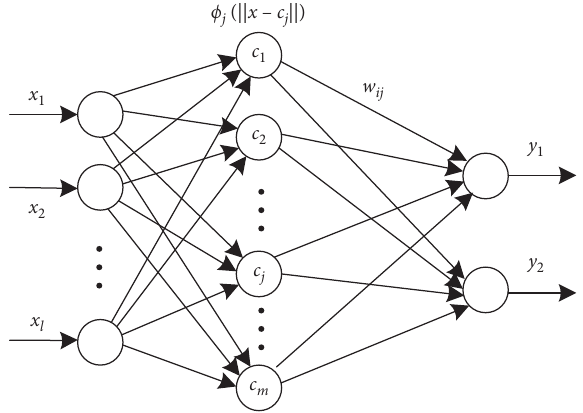
Figure 6: RBF neural network